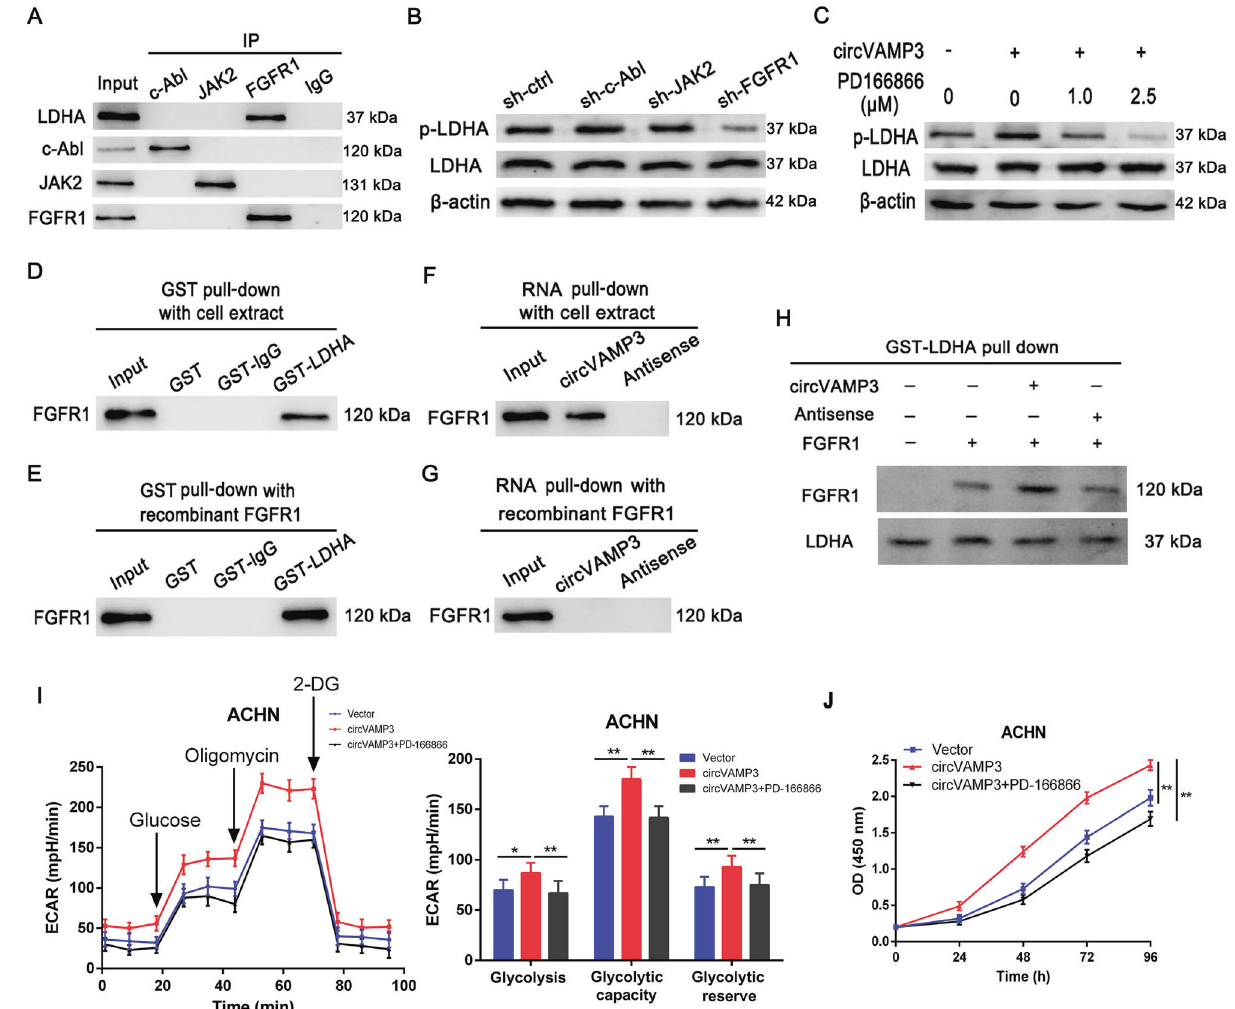
Fig. 6 CircVAMP3 regulates LDHA phosphorylation by FGFR1. A Co-IP analysis of the interaction between endogenous LDHA with c-Abl, JAK2, or FGFR1 in 786-O cells. B The levels of p-LDHA (Y10) and LDHA were examined by western blotting in 786-O cells after silencing the expression of c-Abl, JAK2, or FGFR1. C Western blotting of p-LDHA (Y10) and LDHA expression in the cell lysates. ACHN cells overexpressing circVAMP3 were treated with different concentrations of FGFR1 inhibitor PD-166866 for 24 h. D , E GST pulldown and western blotting with 786-O cell extract ( D ) or puri fi ed recombinant FGFR1 ( E ) assessed the direct interaction between GST-LDHA and FGFR1. lgG: nonspeci fi c control antibody. F , G RNA pulldown and western blotting with 786-O cell extract ( F ) or puri fi ed recombinant FGFR1 ( G ) evaluated the indirect interaction between circVAMP3 and FGFR1. H GST-tagged recombinant LDHA pulldown with recombinant FGFR1, followed by the addition of circVAMP3 or antisense circVAMP3. I ECAR of circVAMP3-overexpressing cells incubated with the FGFR1 inhibitor PD-166866 (2.5 μ M). The values of glycolysis, glycolysis capacity, and glycolytic reserve were calculated. J Cell proliferation was analyzed by CCK-8 assay. For rescue experiments, circVAMP3-overexpressing cells were treated with the FGFR1 inhibitor PD-166866 (2.5 μ M). The results are presented as the mean ± SD. * P < 0.05; ** P <